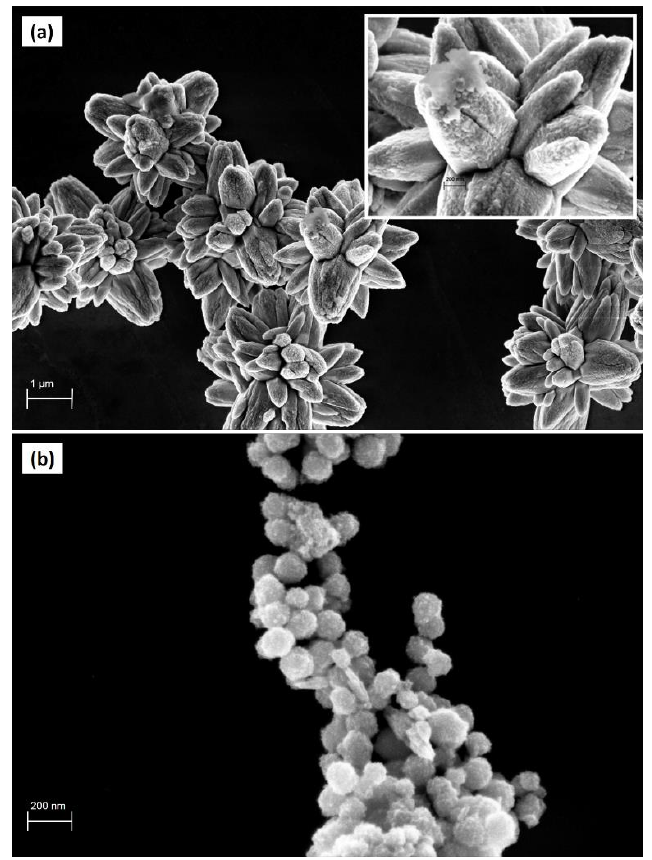
Figure 2. ( a ) FESEM image of ZnO flower-like catalyst; ( b ) FESEM image of ZnO/γ-Fe 2 O 3 composite catalyst.